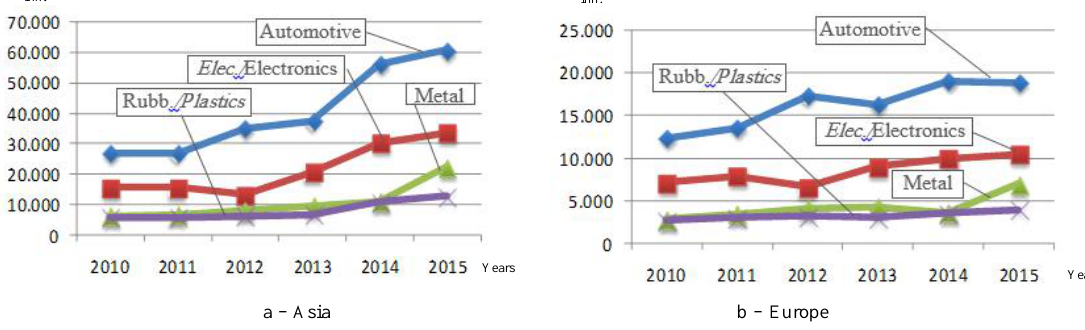
Fig. 5: The application of industrial robots on continents of Asia/Australia and Europe by industry in period 2010-2015 on